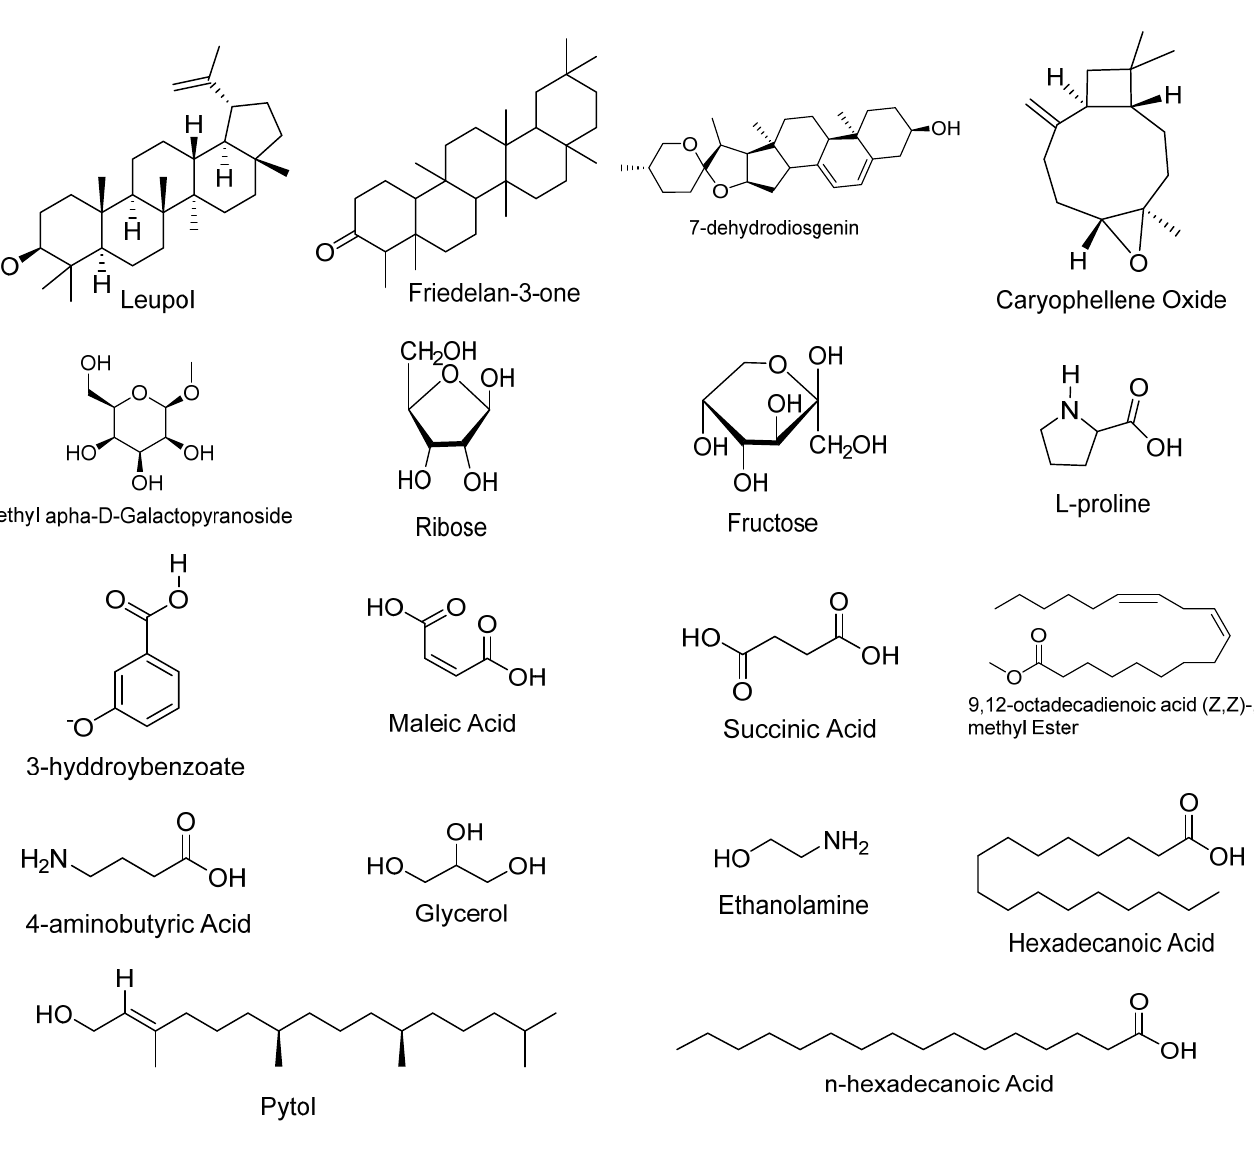
Figure 3. Molecular structures of identified compounds through GC–MS analysis.